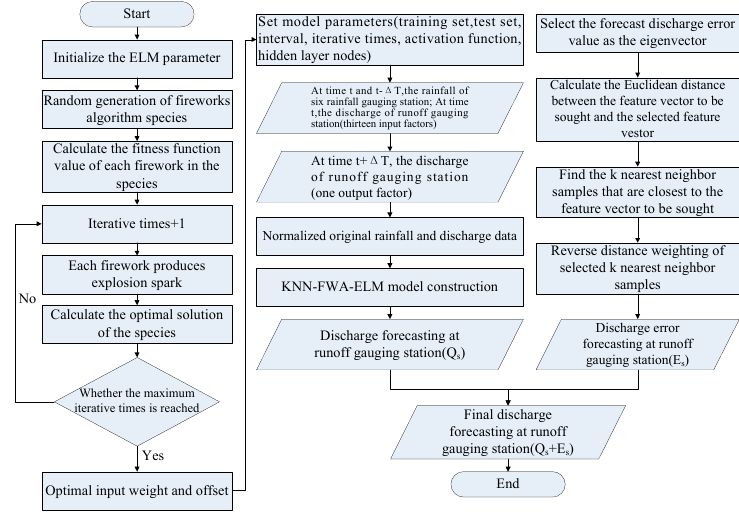
Figure 14. Establishment of the KNN-FWA-ELM model.